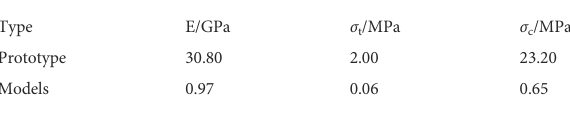
TABLE 4 Prototype and model material parameters for tunnel lining